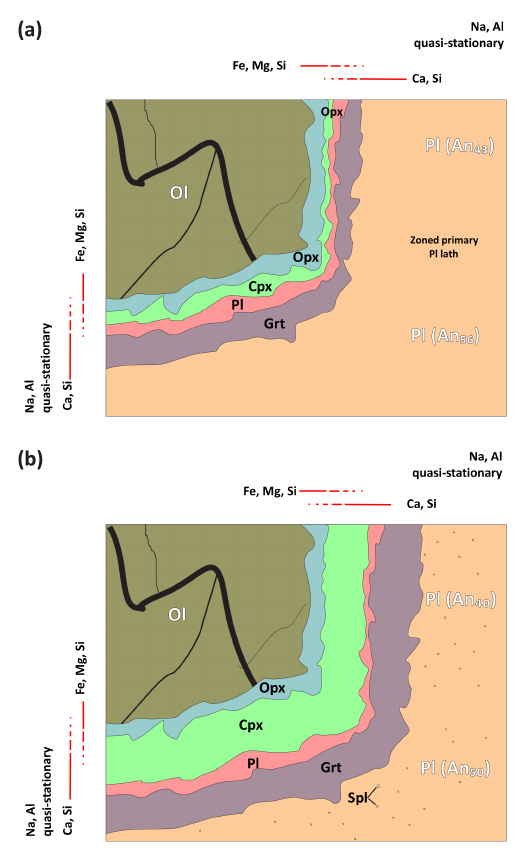
Figure 2. Open-system, single-stage, steady-state diffusion- controlled growth of prograde corona layers between olivine and plagioclase (modified after Johnson and Carlson, 1990). (a) With incipient reaction, different rates of intergranular diffusion for ma- jor components manifest themselves as spatially segregated layers. The corona domain is partitioned into a continuum of compositional subdomains or incipient effective bulk compositions in which lo- cal equilibrium is attained, each with unique chemical potentials. Fe, Mg and Si released from olivine diffuse down chemical poten- tial gradients toward plagioclase, whereas Na, Ca, Al and Si re- leased from plagioclase diffuse toward olivine. Layers comprising the slowest diffusing species (Al) adjoin the most aluminous re- actant. (b) Reactions occur at layer boundaries, and layers expand as diffusion progresses. The width and composition of each corona layer depend on the relative fluxes of the diffusing elements. Mi- nor spinel clouding occurs in reactant plagioclase as Ca and Si dif- fuse preferentially into the reaction band, creating an Si deficiency in reactant plagioclase. Phases in the diagrams are labelled using Kretz (1983) mineral